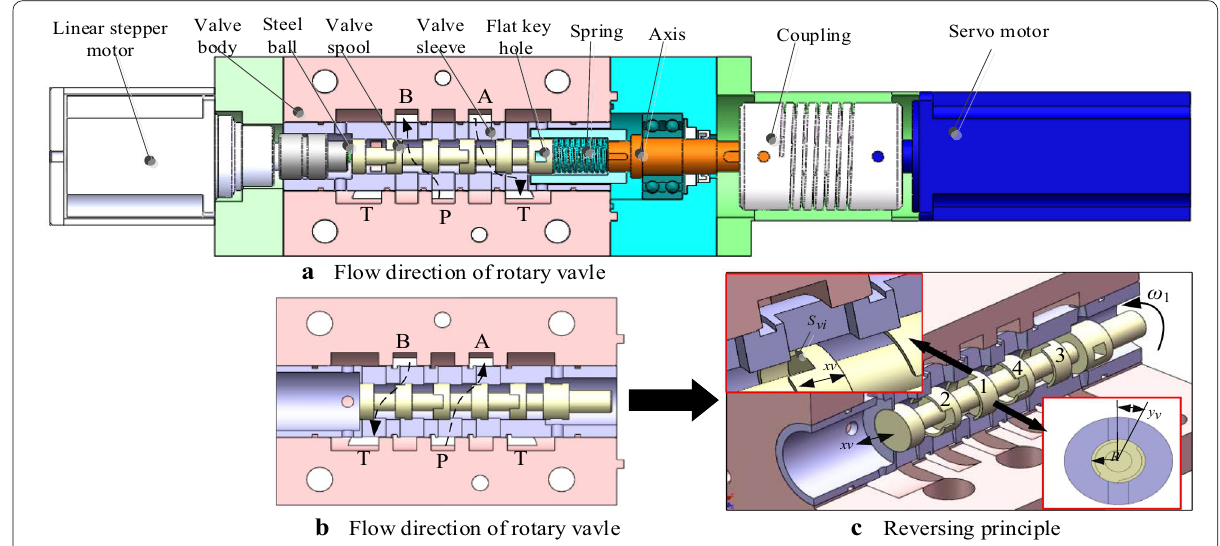
Figure 2 Working principles of digital rotary valve